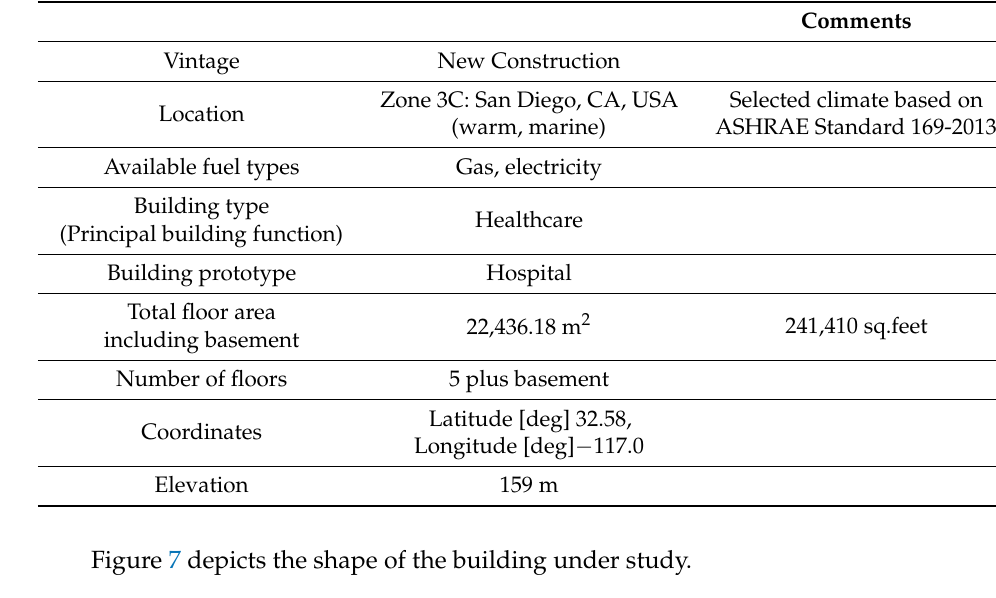
Table 1. Benchmark building’s general specifications.